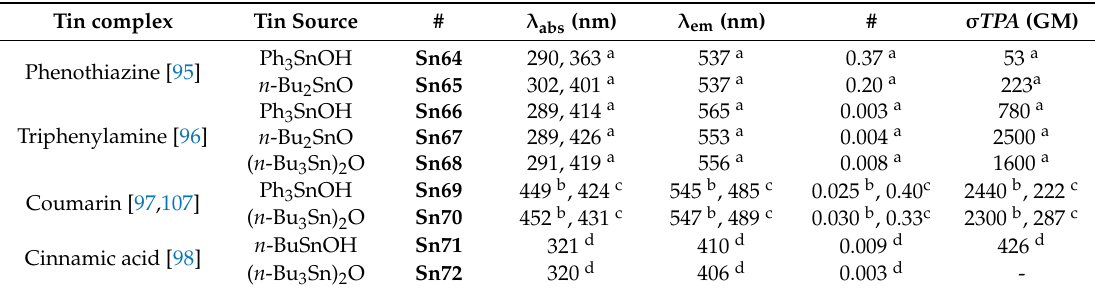
Table 8. Optical properties of the organostannoxanes.